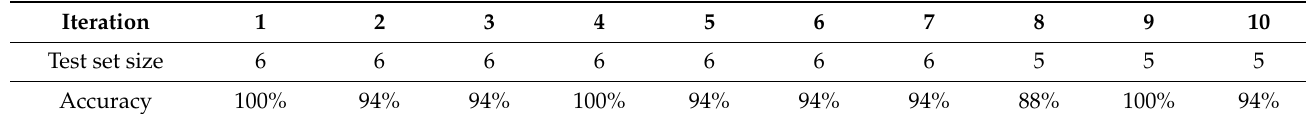
Table 1. Spectrum Classification Accuracy Results.